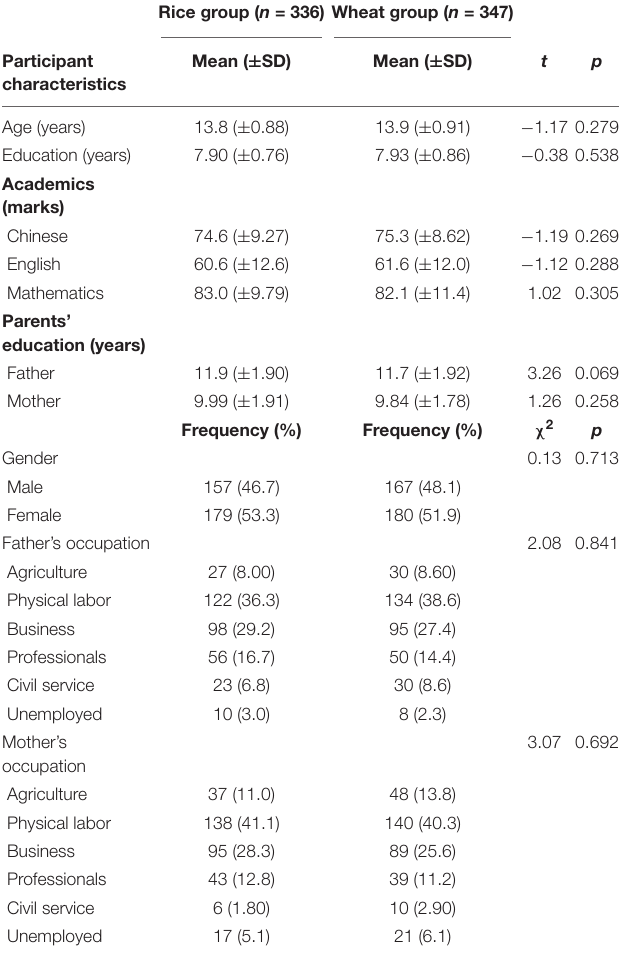
TABLE 1 | Demographic characteristics of the two